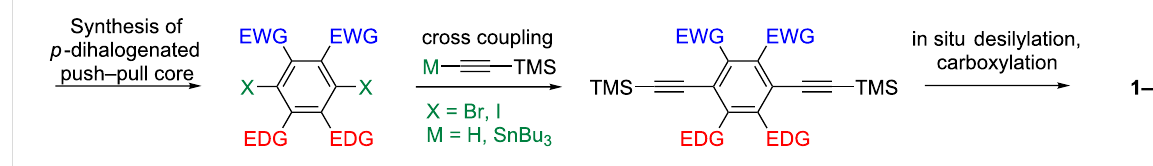
Scheme 1: General synthetic strategy to prepare the dipolar rotors 1 – 5 .